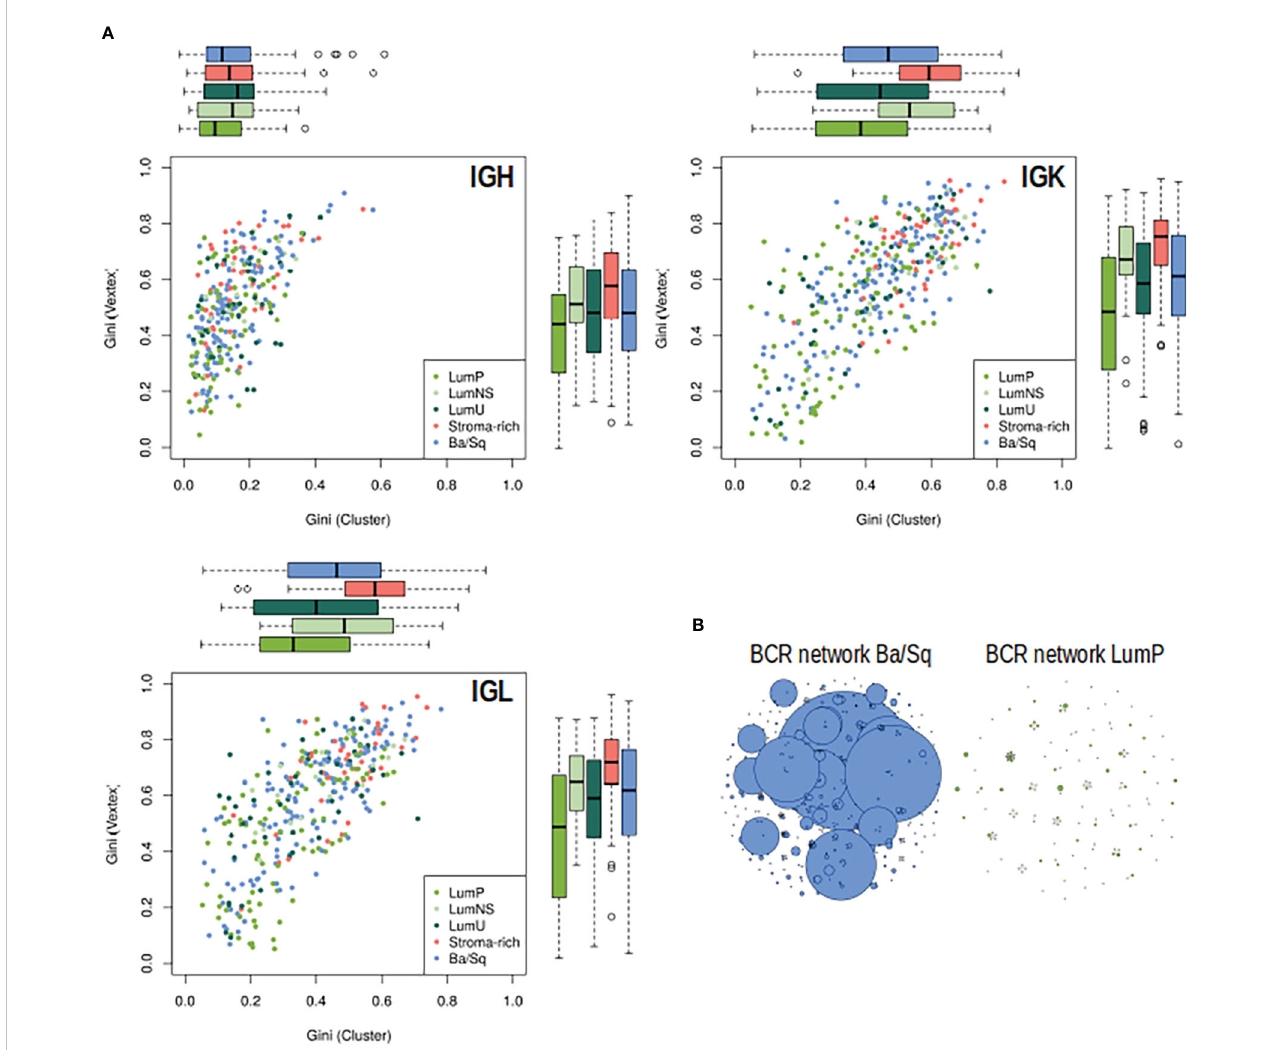
FIGURE 3 BCR clonal expansion and diversi fi cation by subtypes. (A) On the Y axis, clonal expansion is represented by using the Gini Index and on the X axis, clonal diversi fi cation is displayed by Gini Vertex. The plot is colored by subtype, each dot is a MIBC sample and the boxplot represented the distribution of each clonal measurement by subtype. (B) B-cell repertoire networks from two samples representing one Ba/Sq (blue) and one LumP (green). Each vertex represents a unique BCR being the vertex size de fi ned by the number of identical BCRs considering the nucleotide sequences. An edge exists between vertices when they belong to the same clone as de fi ned before, so clusters are groups of interconnected vertices forming a